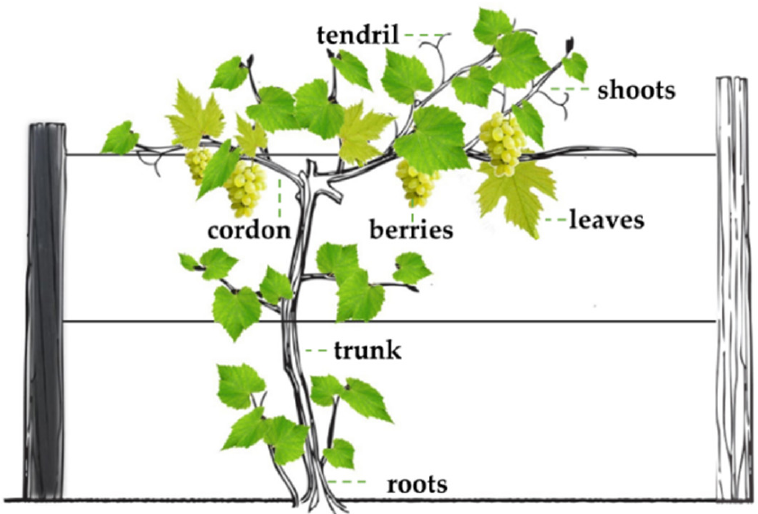
Figure 1. Grapevine structures.